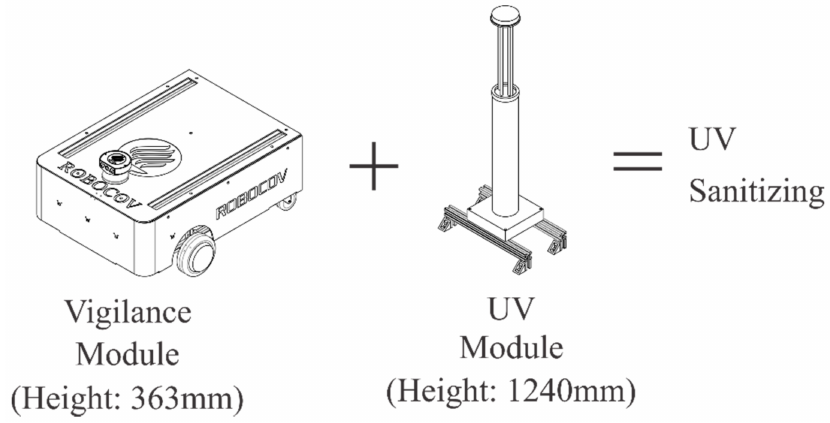
Figure 16. UV disinfection